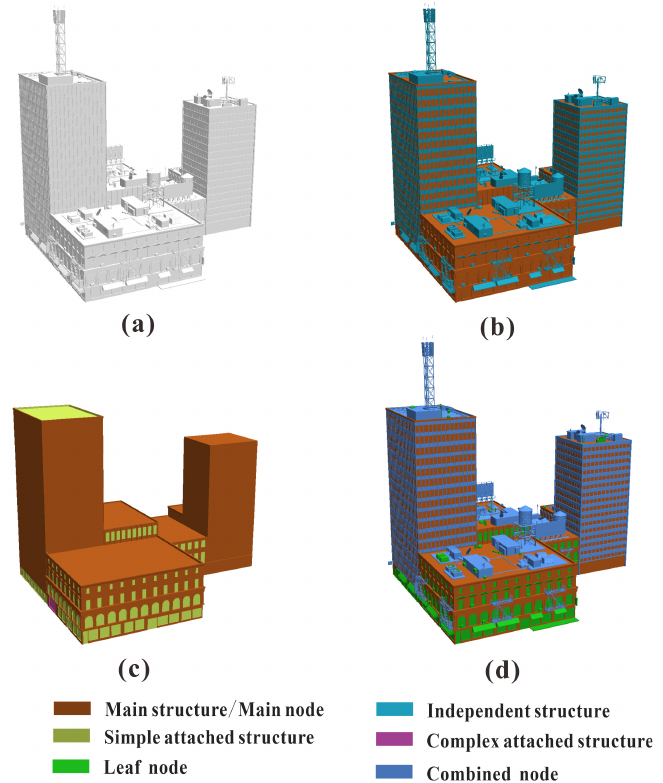
Figure 10. Structure extraction and transmission node construction results of Model 1. ( a ) Original model, ( b ) independent structure extraction results, ( c ) attached structure extraction results and ( d ) transmission node construction results.